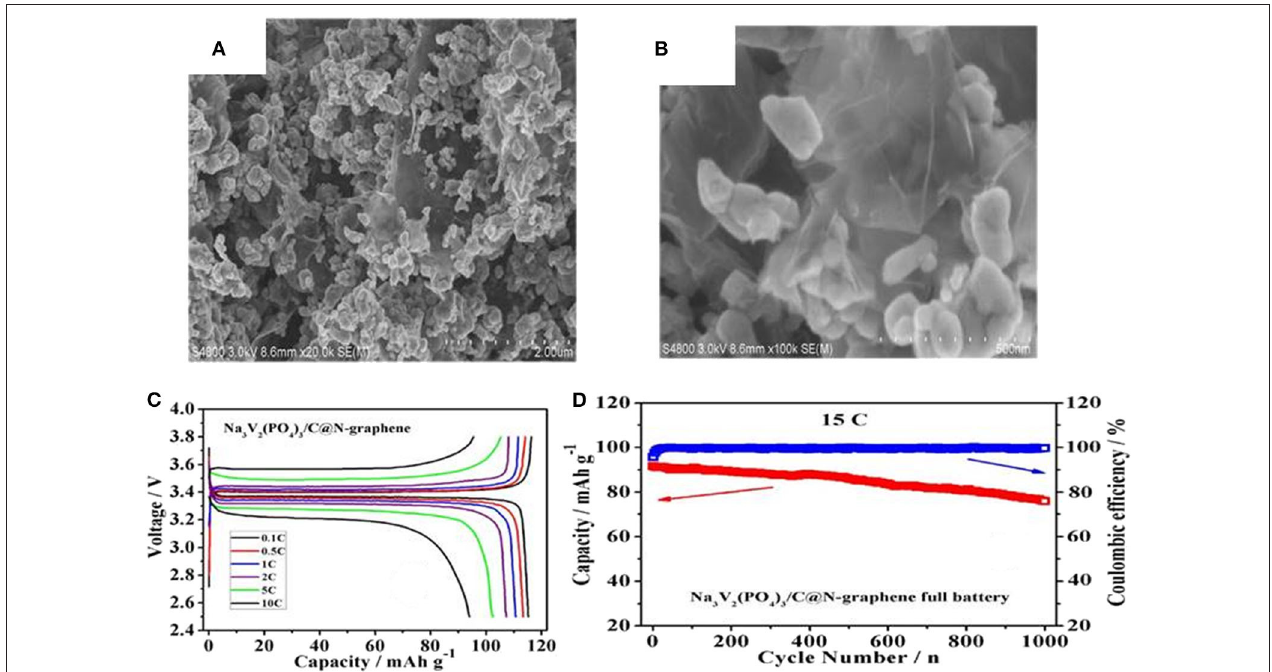
FIGURE 10 | (A,B) SEM image of the NVP/C@N-graphene, (C) charge-discharge curve of NVP/C@N-graphene, (D) cycle property of the NVP/C@N-graphene at 15C.